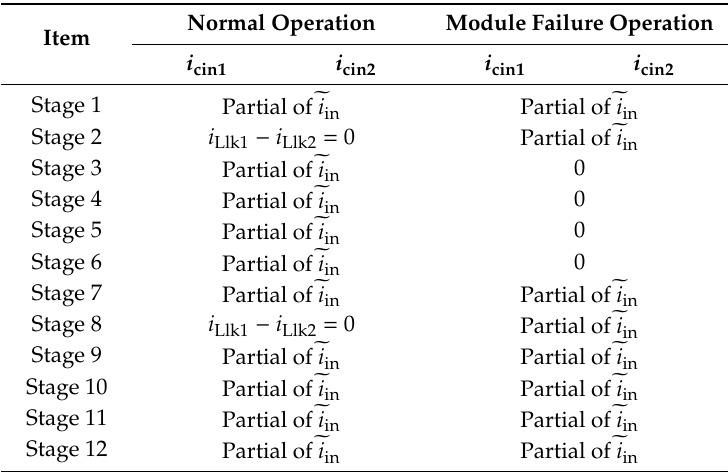
Table 5. Currents of the input capacitors during the secondary side modulation.